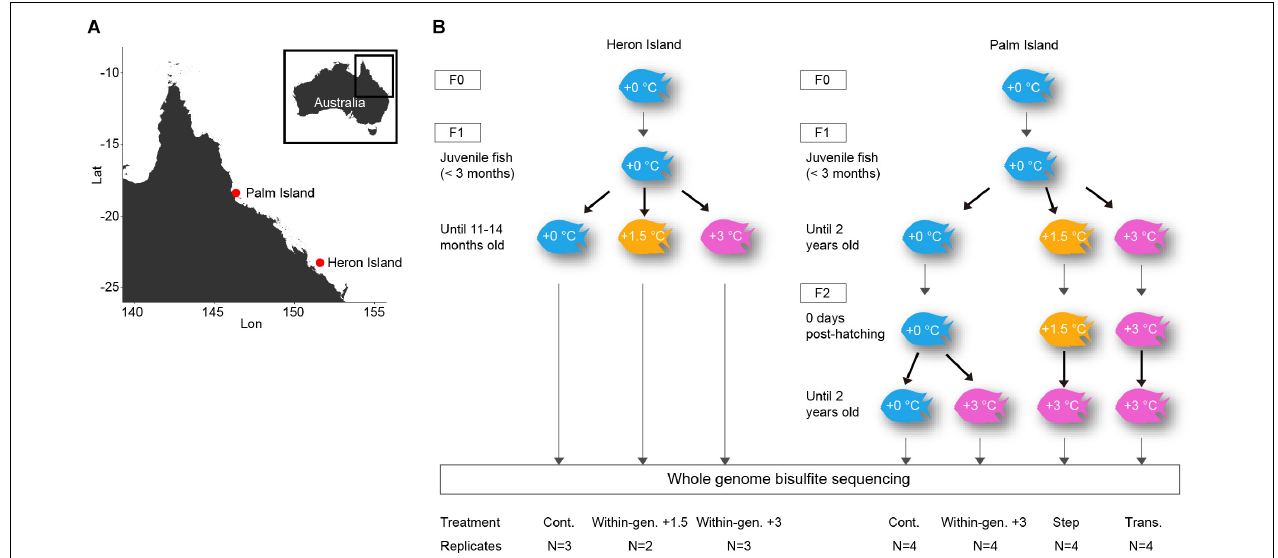
FIGURE 1 | Experimental design to analyze DNA methylation related to thermal plasticity. (A) Sampling location of two populations of A. polyacanthus on the Great Barrier Reef, Australia. (B) Scheme of the fish rearing experiment to study within-generational plasticity (left) and transgenerational plasticity (right).The treatment names and the number of fish samples per treatment (biological replicates) are indicated